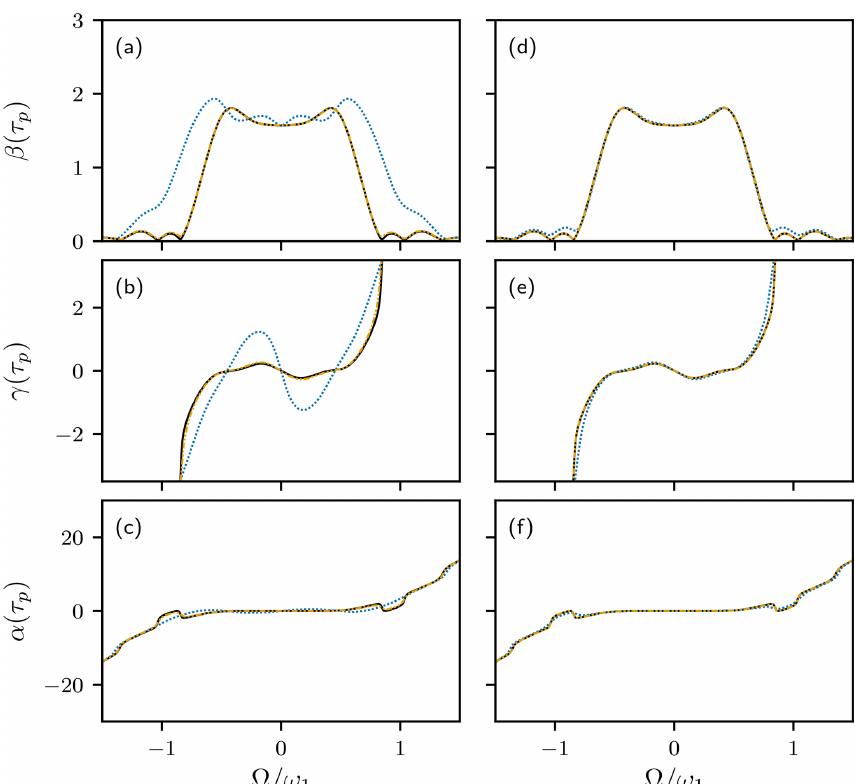
Figure 3. HAM approximations for 90 ◦ Q5 pulse. Numerical calculation of Euler angles α ( τ p ), β ( τ p ), and γ ( τ p ) using Eqs. (1)–(3) (black line). Fifth-order (blue dotted line) and seventh-order (orange dash–dot–dotted line) HAM results, using method 1. Results are shown for (a, b, c) c 0 = − 1 and (d, e, f) c 0 = − 0 . 925. The numerical calculation and seventh-order HAM curves are nearly